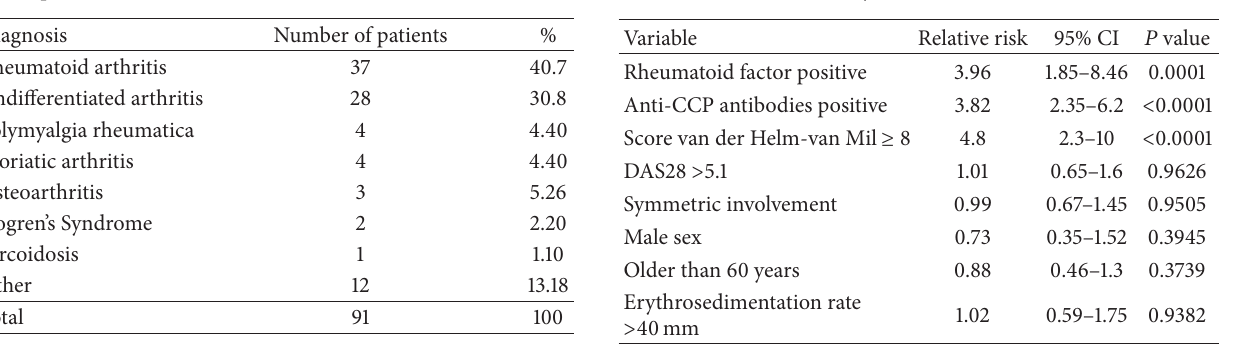
Table 2: Diagnosis fulfilled by patients with early arthritis after followup.